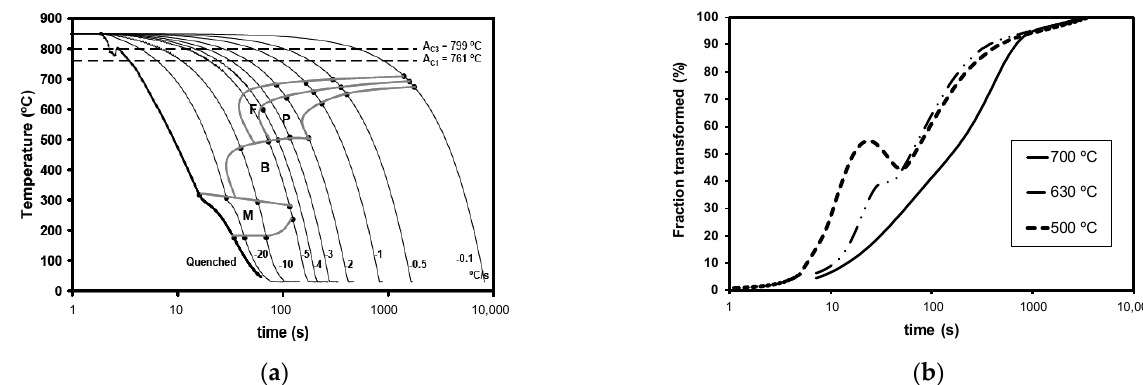
Figure 1. Continuous cooling diagram (austenitization stage performed at 850 °C) ( a ), and transformed fraction on isothermal holding at different temperatures ( b ).